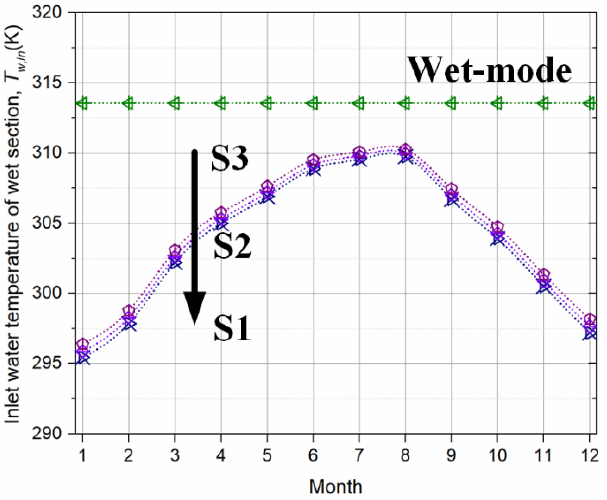
Figure 9. Detailed inlet water temperature of the wet section for different operating strategies.